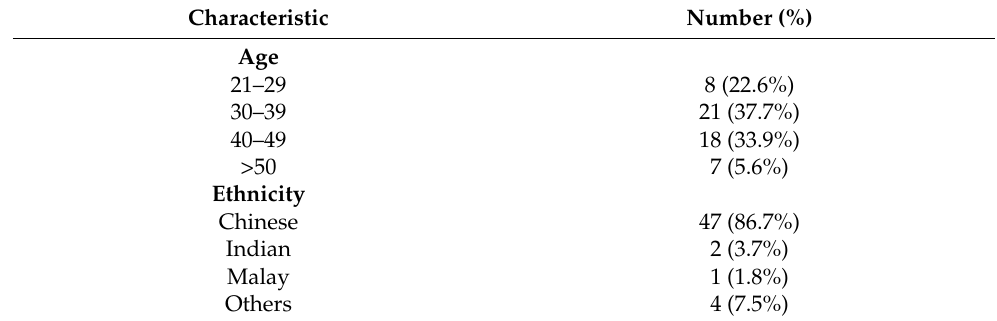
Table 1. Focus group discussion participant characteristics (women without personal history of breast cancer, n =